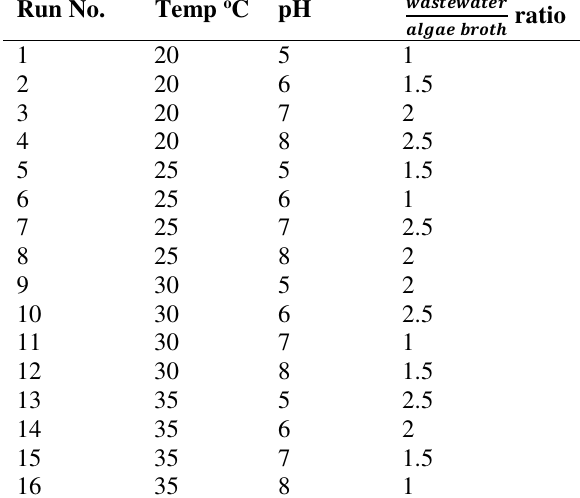
according to the parameters of table